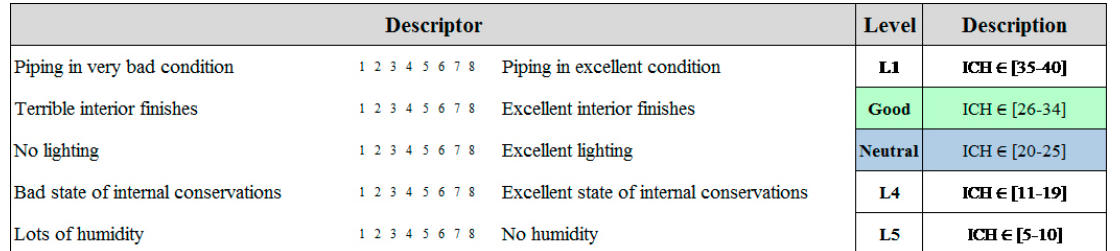
Fig. 3. Descriptor and impact levels of the CTR